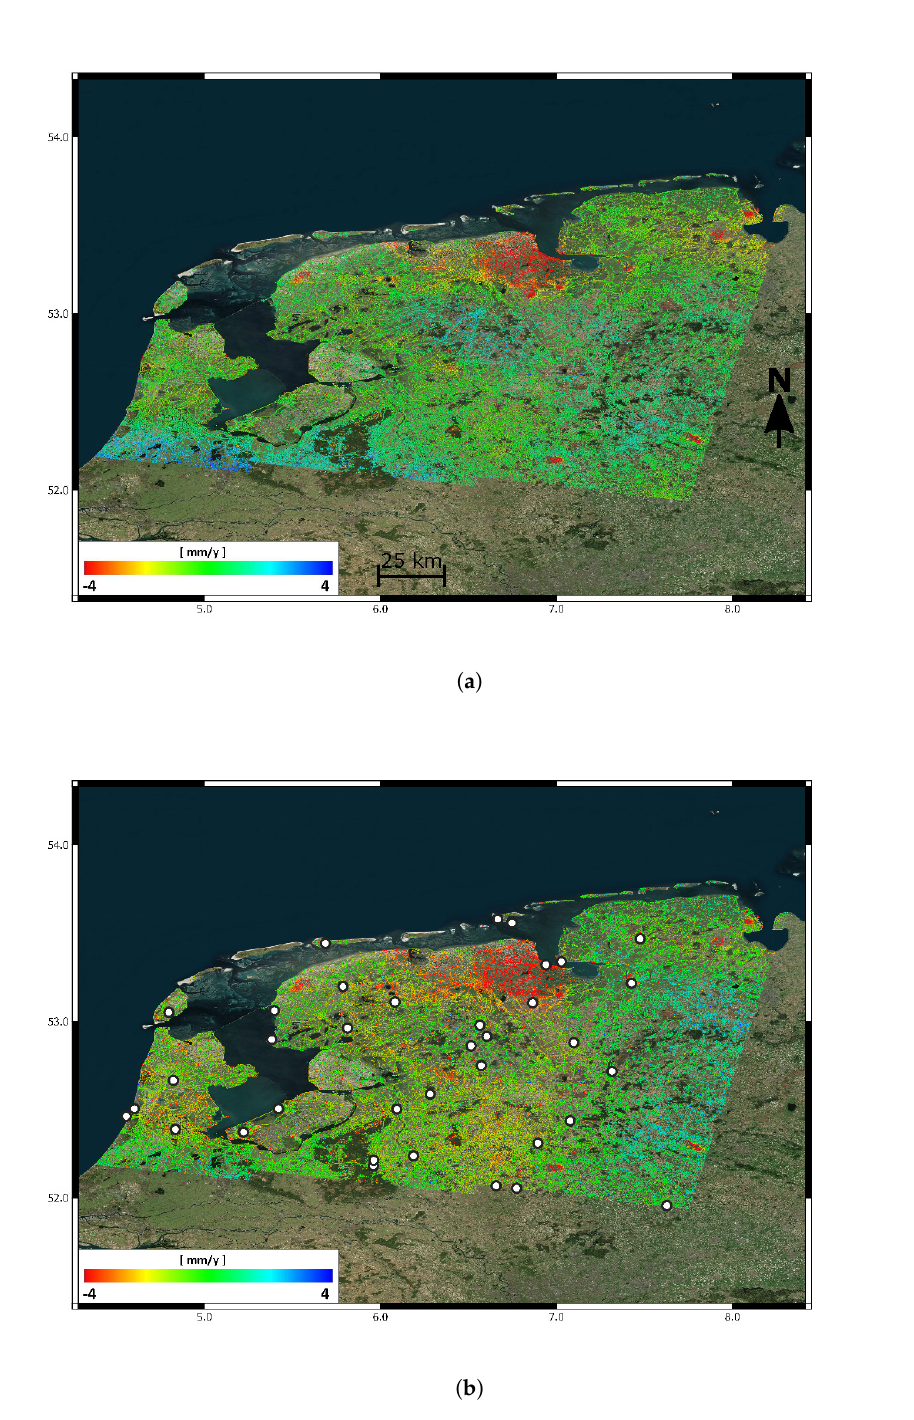
Figure 8. Results for the descending Holland stack, showing ( a ) before and ( b ) after performing merging with GNSS data. In ( b ), the GNSS stations used are displayed with black–white